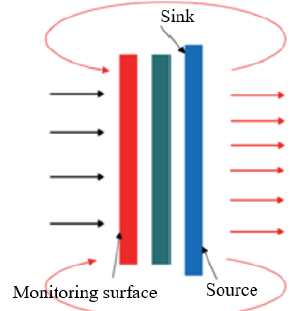
Figure 6. Schematic diagram of air backflow calculation method.